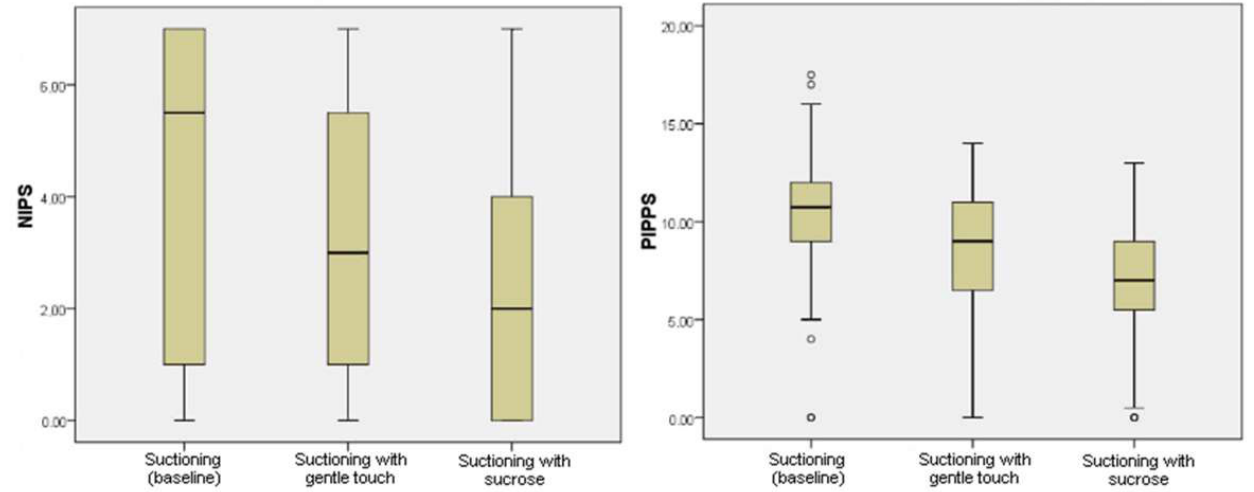
Figure 2. Total NIPS and PIPP-R scores during suctioning procedures (baseline, gentle touch, sucrose).